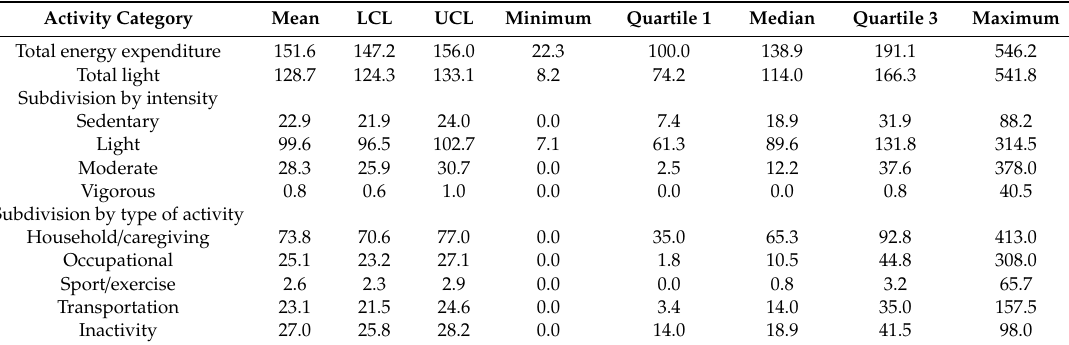
Table 2. Physical activity levels during pregnancy (minutes).